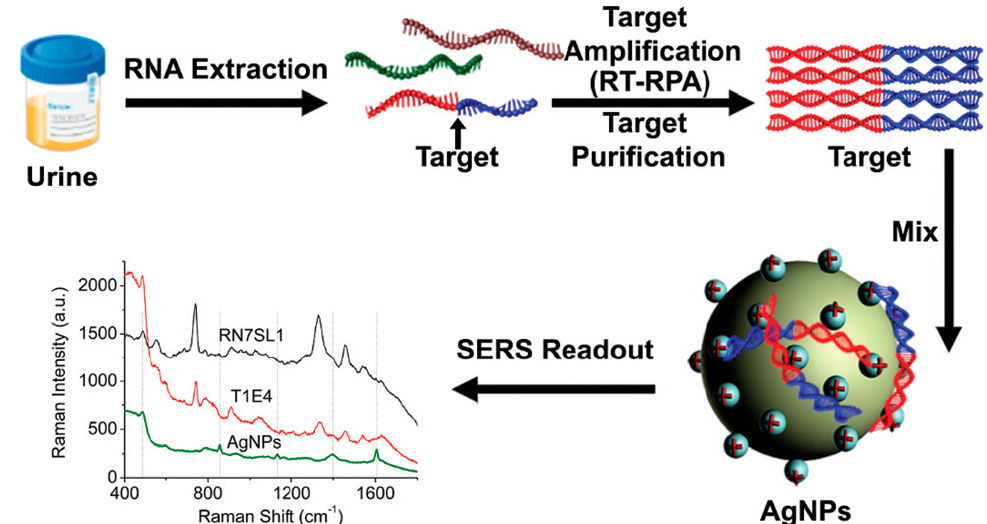
Figure 46. RNA biomarkers detection through label-free SERS. The detection can be represented considering four different steps. Step 1: Extraction of RNA from urinary samples. Step 2: Amplification of target RNA biomarkers into dsDNA sequences, by isothermal transcription- recombinase polymerase amplification (RT-RPA) and purification of samples. Step 3: Incubation of amplicons with positively-charged Ag nanoparticles. Step 4: SERS measurements of colloidal suspensions. Reproduced with permission from Wang et al. [458]. Copyright (2017), the Royal Society of Chemistry.